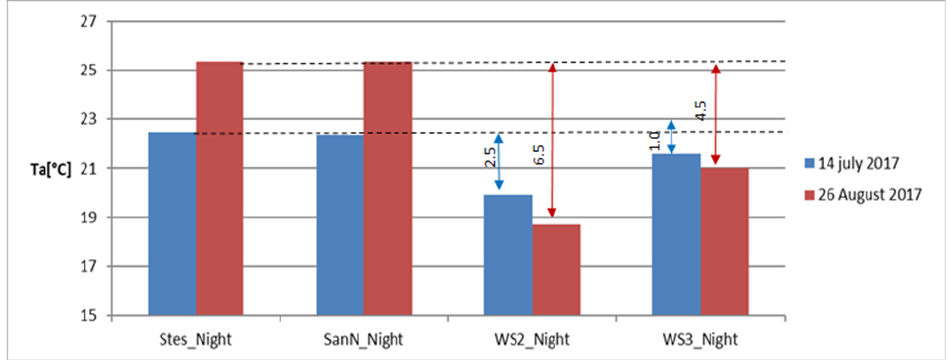
Figure 13. Night time temperature at Stesicoro (Stes), San Nullo (SanN), WS2 and WS3. Assuming the WS2 location as reference for the rural area , a ΔTu -r of 6.5°C can be observed. Conversely, assuming the WS3 location as reference, a ΔTu -r of 2.5° is obtained. This result is coherent with the location of WS2, which is placed closest to the city centre with respect to WS3.